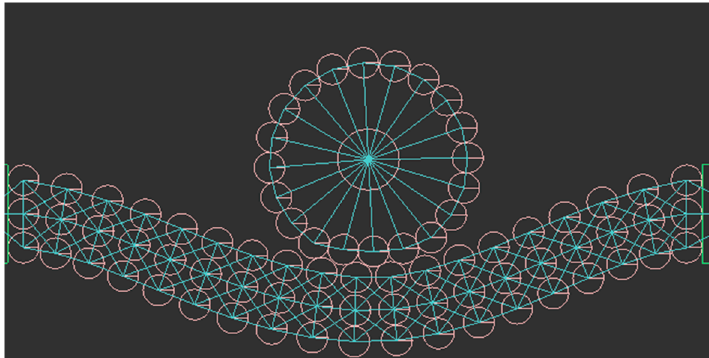
Figure 3. An example of a deformed polygon-shaped body and a circle-shaped body.